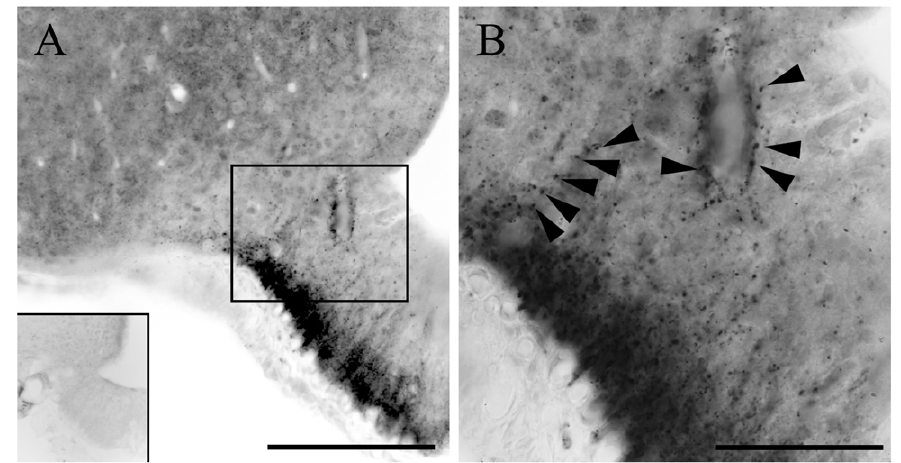
Figure 1. D3 immunoreactivity in the rat mediobasal hypothalamus. ( A ) Abundant D3 immunoreactive structures are seen in the external zone of the rat median eminence marked by silver grains. The inset on the left demonstrates the complete disappearance of D3- immunoractivity from the MBH when sections were incubated with D3 antisera previously preabsorbed with the corresponding peptide antigen. The boxed region is enlarged in ( B ). Black arrowheads indicate immunoreactive loci, which frequently were adjacent to blood vessels. Scale bars: 50 m m in A, 20 m m in B.